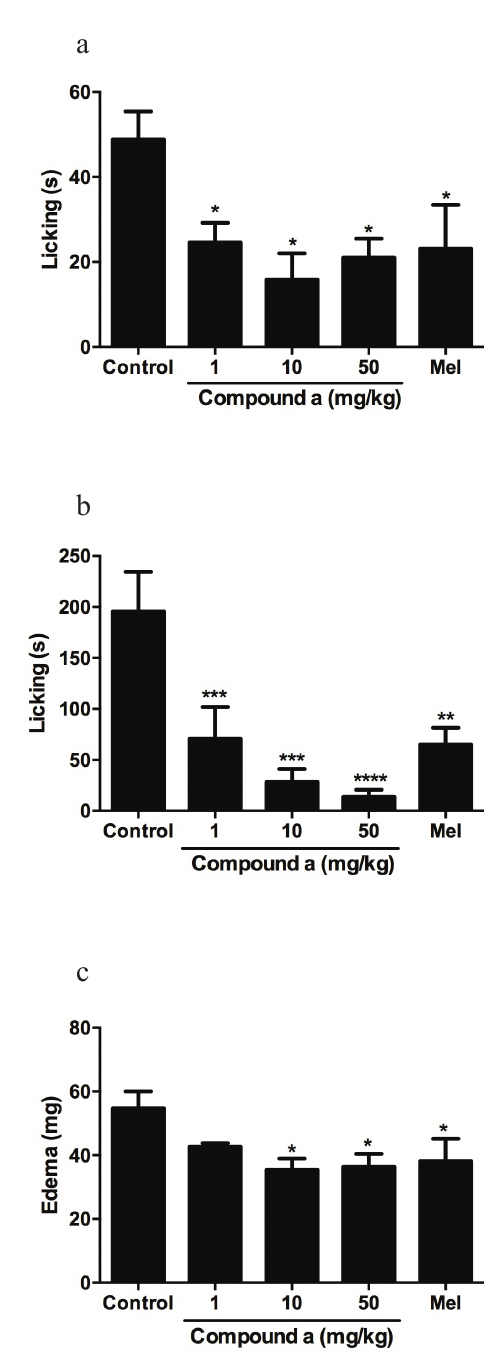
Figure 3 - Effects of compound a on formalin-induced nociception. Inhibition of the formalin-induced licking (s) response (a) in the first and (b) second phases, and (c) edema (mg). Data are reported as mean ± S.E.M of 7 to 8 animals per group. Statistical analysis was performed by One-way ANOVA followed by Newman-Keuls’ test. (*) denotes P < 0.05, (**) denotes P < 0.01 and (***) denotes P < 0.001 when compared to the control